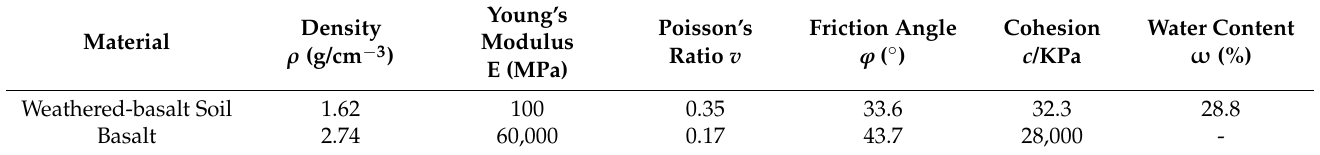
Table 3. FE model parameters of the Azhuoluo slope.